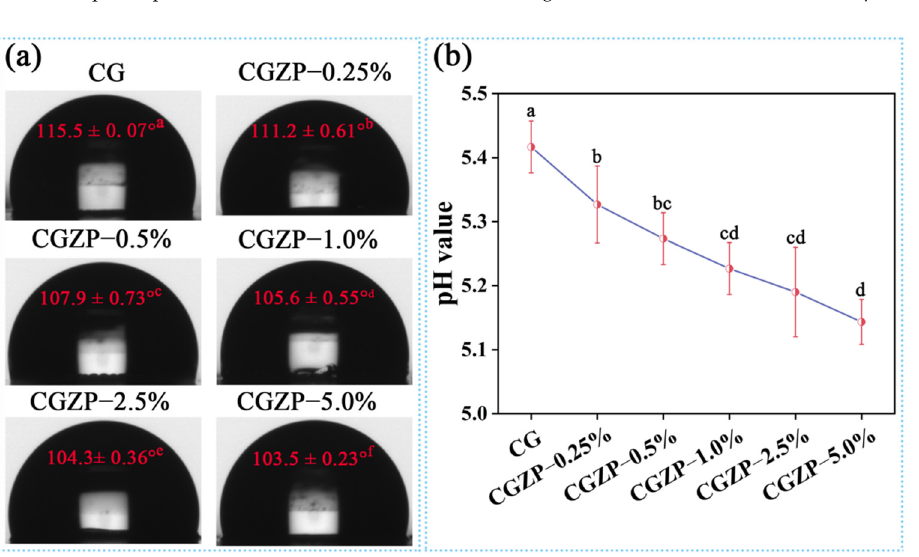
Different superscript letters in the same column demonstrate significant difference between values ( p < 0.05).